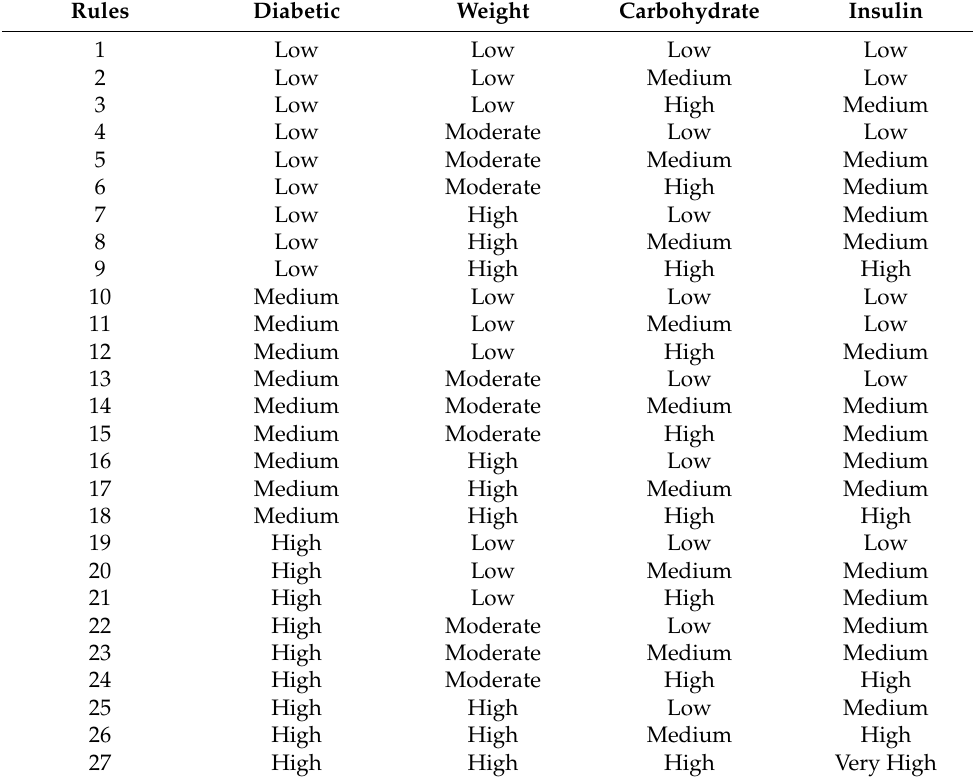
Table 3. Rules for